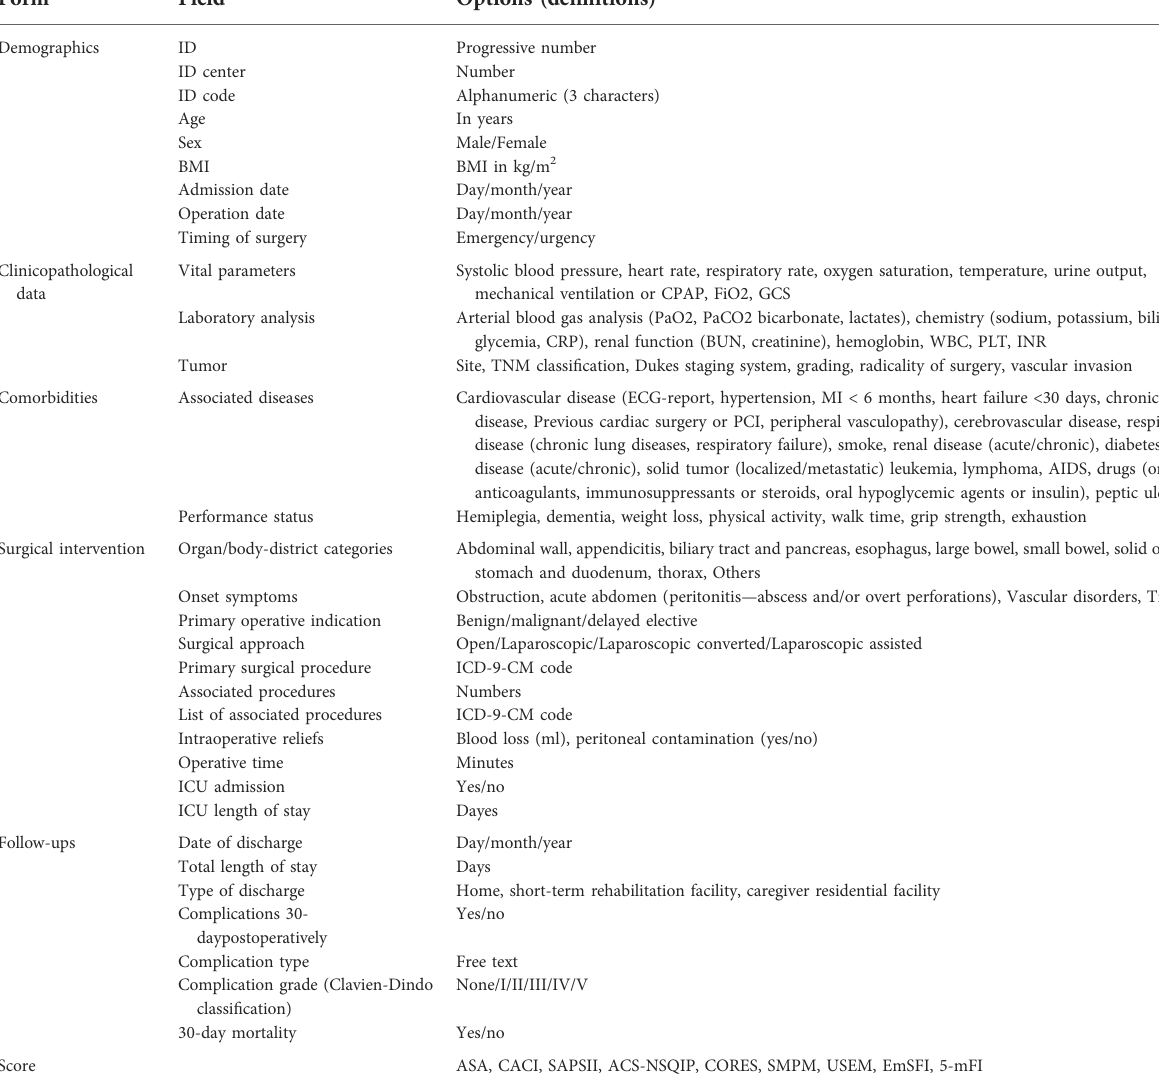
TABLE 1 Data spreadsheet fi elds: ASA American society of anaesthesiologists, BMI body mass index, BUN blood urea nitrogen, CPAP continuous positive airway pressure, CRP C-reactive protein, GCS glasgow coma scale, ICD-9-CM 9th revision of international classi fi cation of disease clinical modi fi cation, ID identi fi er, INR international normalized ratio, MI myocardial infarction, mFI modi fi ed frailty Index, PCI percutaneous coronary intervention, PLT platelet, WBC white blood cell, P-POSSUM portsmouth-physiological and operative severity score for the enUmeration of mortality and morbidity, CR-POSSUM coloRectal physiological and operative severity score for the enUmeration of mortality and morbidity, SAPS II simpli fi ed acute physiology score II, CACI charlson age-comorbidity index, EmSFI emergency surgical frailty